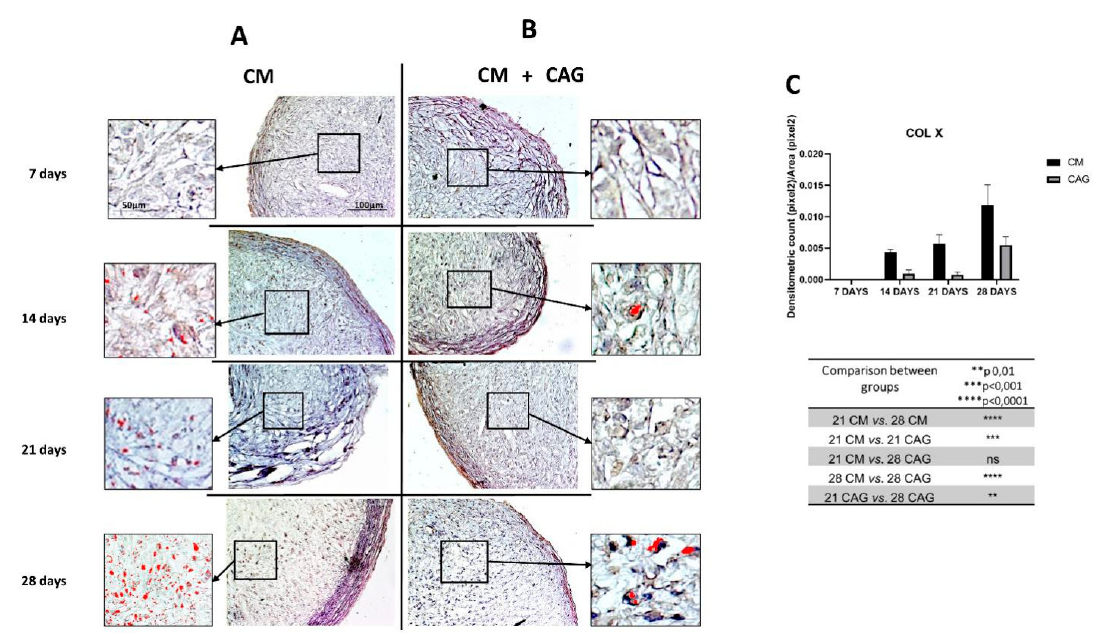
Figure 7. Col type X immunohistochemical evaluation in 3D AMSC-derived chondropellets at 7, 14, 21, and 28 days of culture through computerized densitometric measurements and image analysis. ( A ) control group (chondrogenic medium: CM); ( B ) CAG-supplemented group (CM + CAG). The inserts represent the image magnifications (objective lens, 20×; scale bar: 50 μ m), to evidence the image analyses by the software in the pellet middle zone: red color corresponds to brown staining (immune complexes labelled with chromogen). ( C ) Graph representing the level of staining expressed as densitometric count (pixel 2 ) normalized to the area of each section expressed in pixel 2 . Results were presented as the mean ± SD. ANOVA was used to evaluate the significance of the results. ** p < 0.01; *** p < 0.001; **** p < 0.0001; ns, not significant. See the Materials and Methods section for details. Objective lens, 10×; scale bar: 100 μ m.